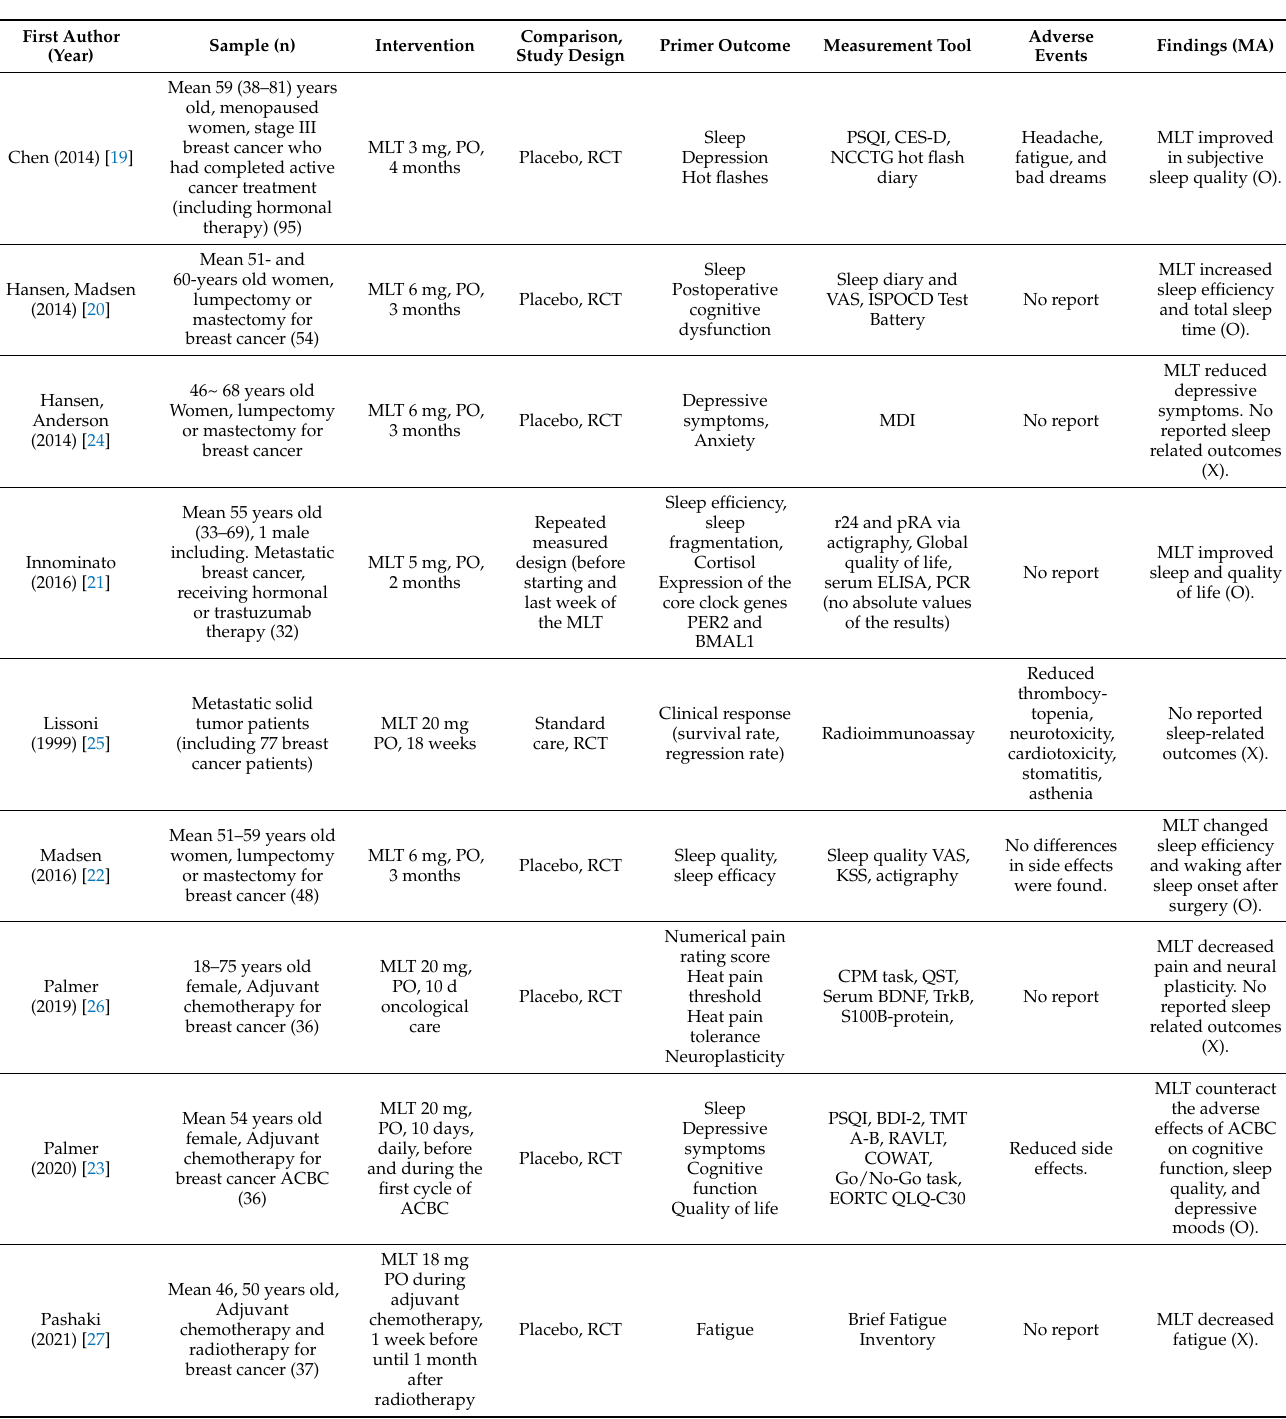
Table 1. Characteristics of the studies providing melatonin to breast cancer